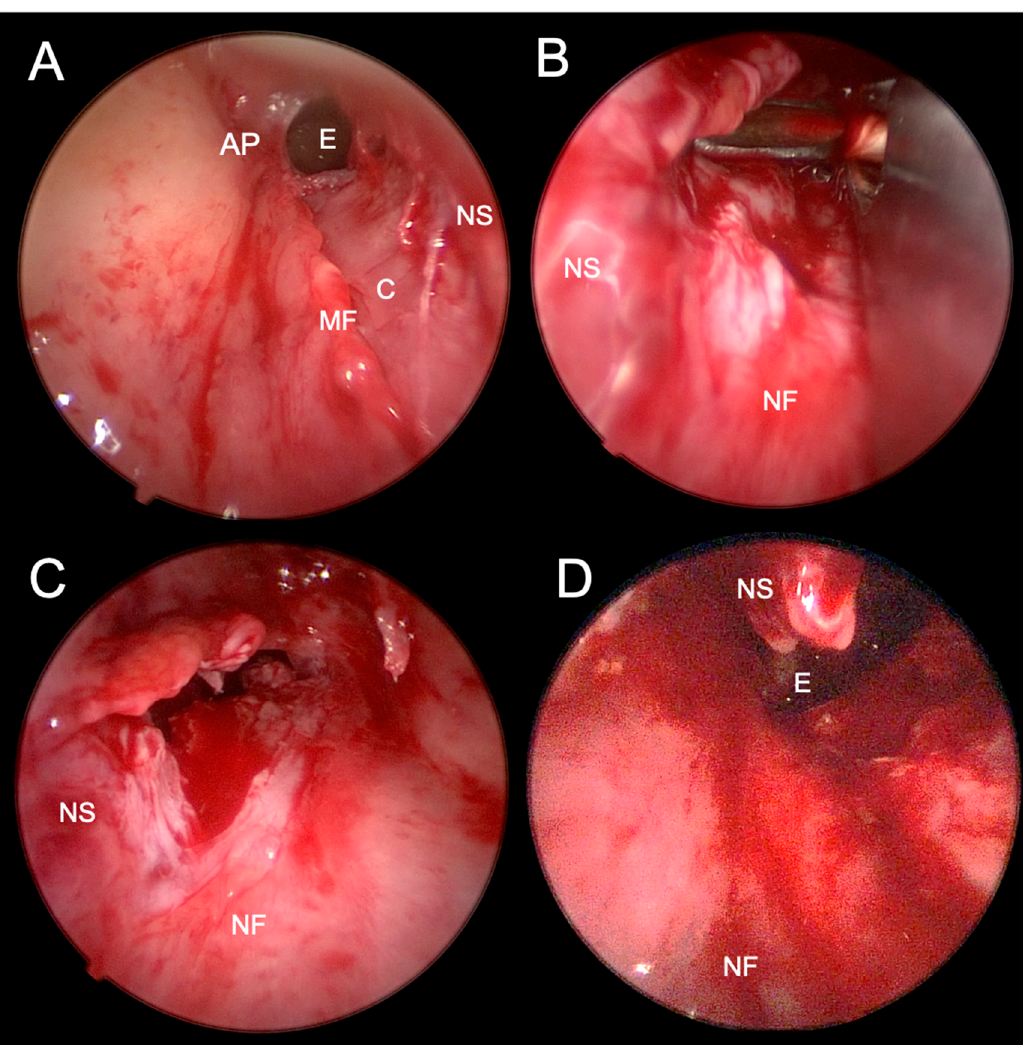
Figure 7. Endoscopic photographs of transnasal endoscopic choanoplasty of bilateral choanal atresia. ( A )–after perforation of the atretic plate of the right nasal cavity and elevation of the mucoperichondrial flap of the nasal septum and atretic plate. ( B )–resection of the posterior nasal septum with forceps through the left nasal cavity. ( C )–after partial resection of the posterior nasal septum visible through the left nasal cavity. ( D )–after a partially surgically formed unichoana, which connects both nasal cavities in the posterior nasal septum resection area. AP–atretic plate; E–epipharynx; C–carti-